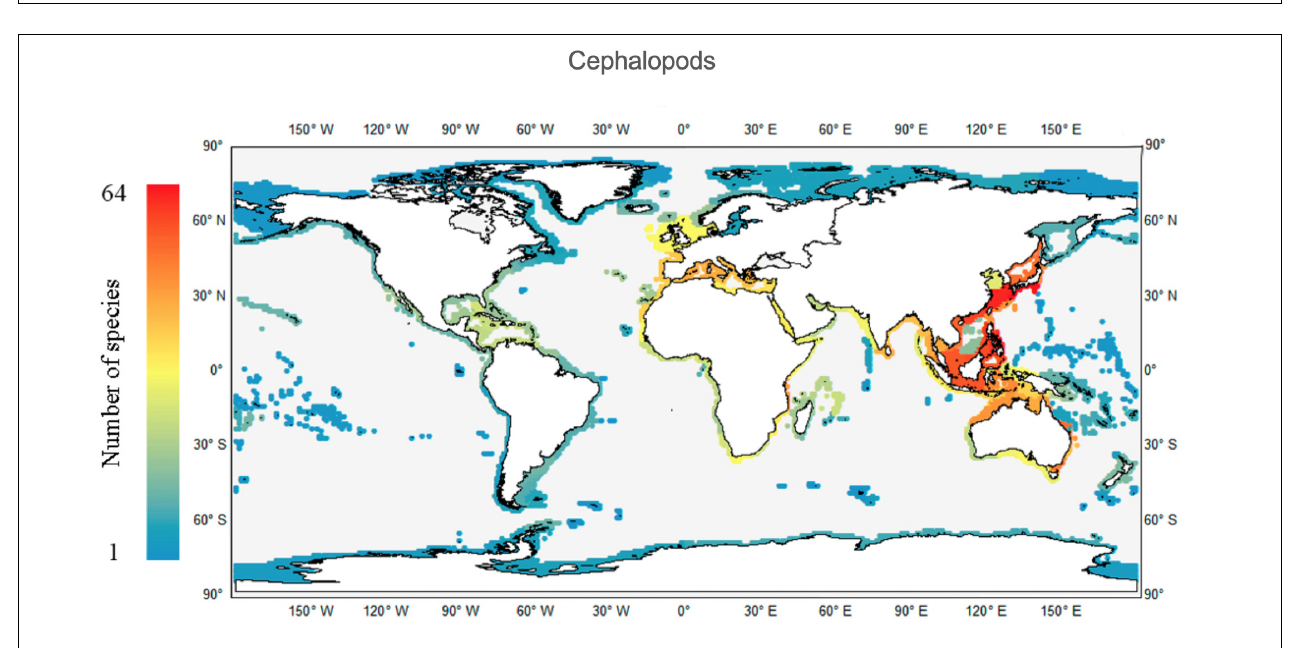
FIGURE 3 | Dissimilarity index of cuttlefishes (Family Sepiidae; A ), bobtails (Family Sepiolidae; B ), bottletails (Family Sepiadariidae; C ), pygmy squids (Family Idiosepiidae; D ), inshore squids (Family Loliginidae; E ), octopuses (Families Octopodidae, Eledonidae, Enteroctopodidae, Megaleledonidae, and Bathypolypodidae; F ), and overall (total cephalopods; G ). Arctic (ARC; light blue in lower panel), Temperate Northern Atlantic (TNA; blue), Tropical Atlantic (TAT; dark blue), Temperate Southern Africa (TSAF; light brown), Western Indo-Pacific (WIP; brown), Temperate Australasia (TAUS; purple), Central Indo-Pacific (CIP; dark red), Temperate Northern Pacific (TNP; red), Eastern Indo-Pacific (EIP; orange), Tropical Eastern Pacific (TEP, yellow), Temperate South America (TSA; green), Southern Ocean (SO; dark gray). (H) Is for easy reference to the different realms.